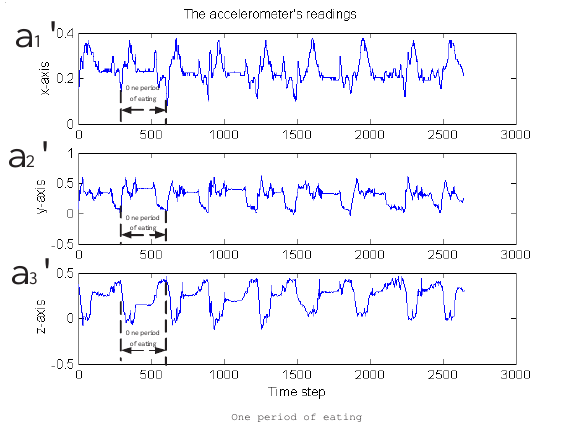
Figure 7. The raw sensor data from the 3 axis accelerometer of eating action.